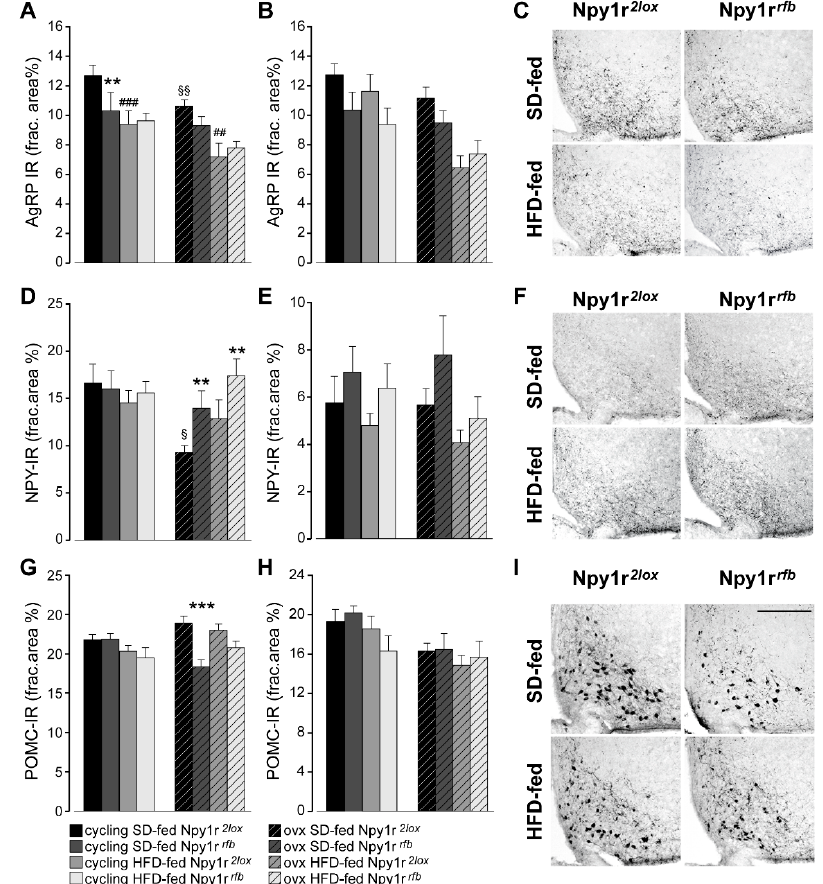
Figure 4. Expression of neuropeptides in the ARC and PVN of standard diet (SD)- and high-fat diet (HFD)-fed cycling and ovx Npy1r 2lox control and Npy1r rfb knockout female mice. Agouti-related protein immunoreactivity (AgRP-IR) in the ARC ( A ) and in the PVN ( B ) of SD- and HFD-fed cycling and ovx Npy1r 2lox and Npy1r rfb females. HFD and ovx significantly decreased AgRP expression in the ARC of female mice. SD-fed cycling Npy1r rfb conditional mutants showed a significant decrease of AgRP-IR in the ARC compared to SD-fed cycling control females. Data are the mean ± SEM; n = 8–9 (ARC) and n = 7–10 (PVN) from 2 litters. ** p < 0.01 and ### p < 0.001 versus SD-fed cycling Npy1r 2lox females; §§ p < 0.01 versus SD-fed cycling Npy1r 2lox ; mice; ## p < 0.01 versus SD-fed ovx Npy1r 2lox female mice. ( C ) Representative images of the ARC of ovx females expressing AgRP-IR immunoreactivity (scale bar: 150 µ m). Neuropeptide Y immunoreactivity (NPY-IR) in the ARC ( D ) and in the PVN ( E ) of SD- and HFD-fed cycling and ovx Npy1r 2lox and Npy1r rfb females. A significant decrease of NPY-IR was observed in the ARC of ovx Npy1r 2lox mice compared with cycling Npy1r 2lox mice. A significant increase of NPY-IR was observed in the ARC of ovariectomized Npy1r rfb mice compared with their control littermates on the same diet regimen. § p < 0.05 versus cycling Npy1r 2lox females on the same diet regimen. ** p < 0.01 versus ovx Npy1r 2lox on the same diet regimen. Data are the mean ± SEM; n = 5–8 from 2 litters. ( F ) Representative images of the ARC of ovx females expressing NPY-IR immunoreactivity (scale bar: 150 µ m). Proopiomelanocortin immunoreactivity (POMC-IR) in the ARC ( G ) and in the PVN ( H ) of SD- and HFD-fed cycling and ovx Npy1r 2lox and Npy1r rfb females. A significant decrease of POMC-IR was observed in the ARC of SD-fed ovx Npy1r rfb mice compared with SD-fed ovx Npy1r 2lox mice. Data are the mean ± SEM; n = 7–11 from 2 litters. *** p < 0.001 versus SD-fed ovx Npy1r 2lox mice. ( I ) Representative images of the ARC of ovx females expressing POMC-IR (scale bar: 150 µ